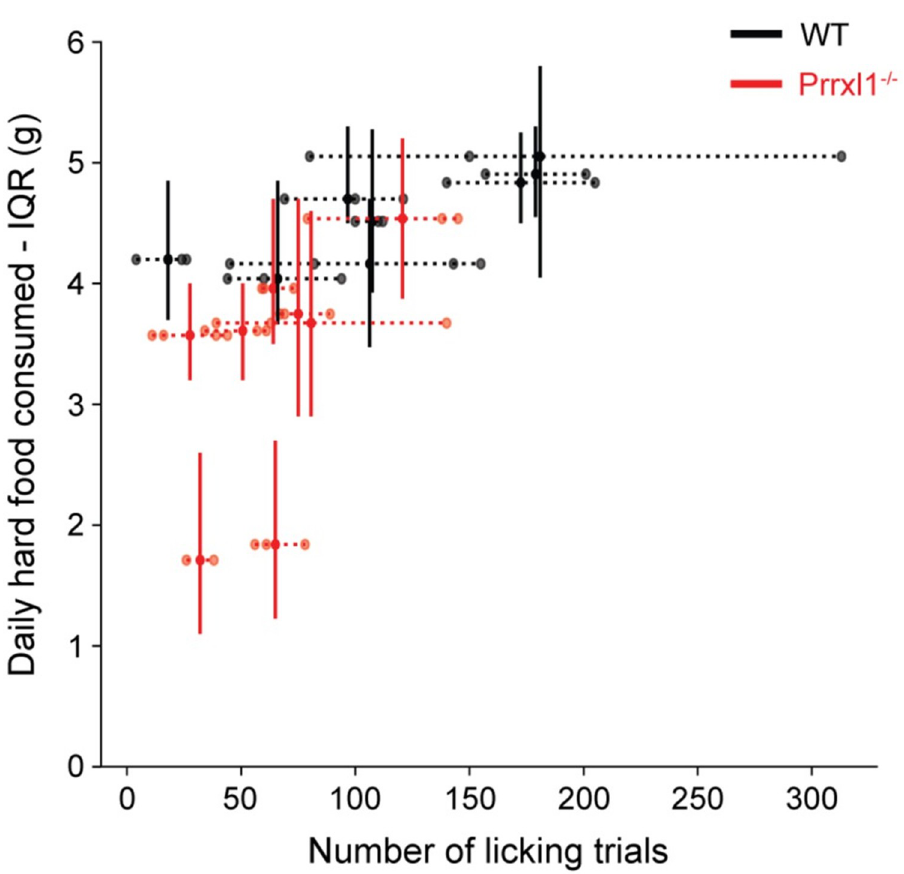
Fig 6. A comparison of food consumption and the number of licking trials. Within a genotype, animals that performed more licking trials also ate more and animals that ate less tended to perform fewer licking trials. Two of the eight mutant animals (#13 and #14) display more severe food intake issues. Both groups occupy separate regions that partially overlap, suggesting two functionally distinct group in this projection of the ingestive behavior space.